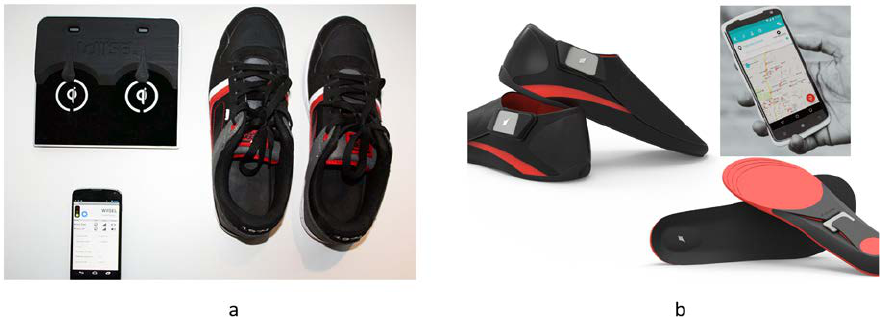
Figure 5. ( a ) Wiisel footwear system for fall risk application; and ( b ) Lechal system ® for by Ducere Technologies Pvt. Ltd. (Secunderabad, Andhra Pradesh, India).